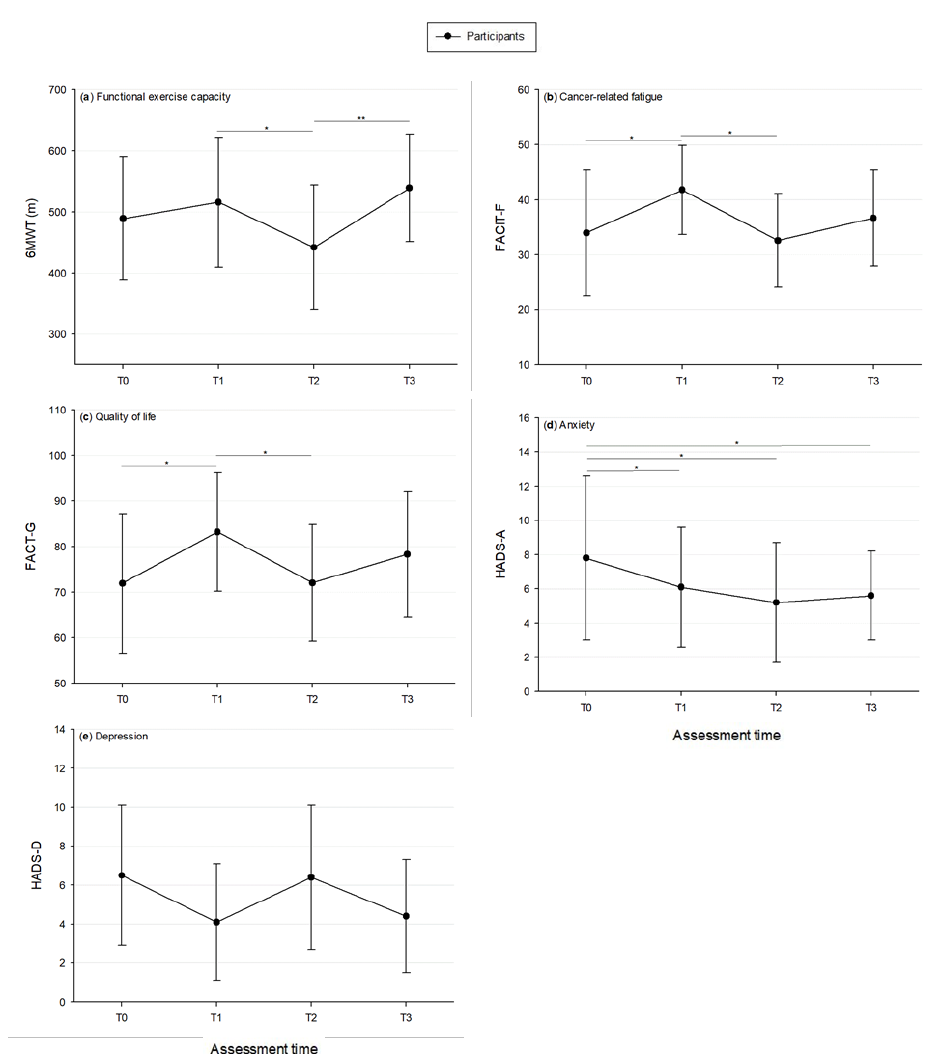
Figure 2. Evolution of ( a ) The 6 min walk test (6MWT); ( b ) The Functional Assessment of Chronic Illness Therapy-Fatigue Scale (FACIT-F); ( c ) The Functional Assessment of Cancer Therapy-General (FACT-G); ( d ) The Hospital Anxiety and Depression Scale-anxiety (HADS-A), and ( e ) The Hospital Anxiety and Depression Scale-depression (HADS-D) throughout the study. T0—at the beginning of the prehabilitation program; T1—at the end of prehabilitation; T2—4 weeks postsurgery; T3—12 weeks postsurgery. Data are mean ± SD. * p < 0.05; ** p <